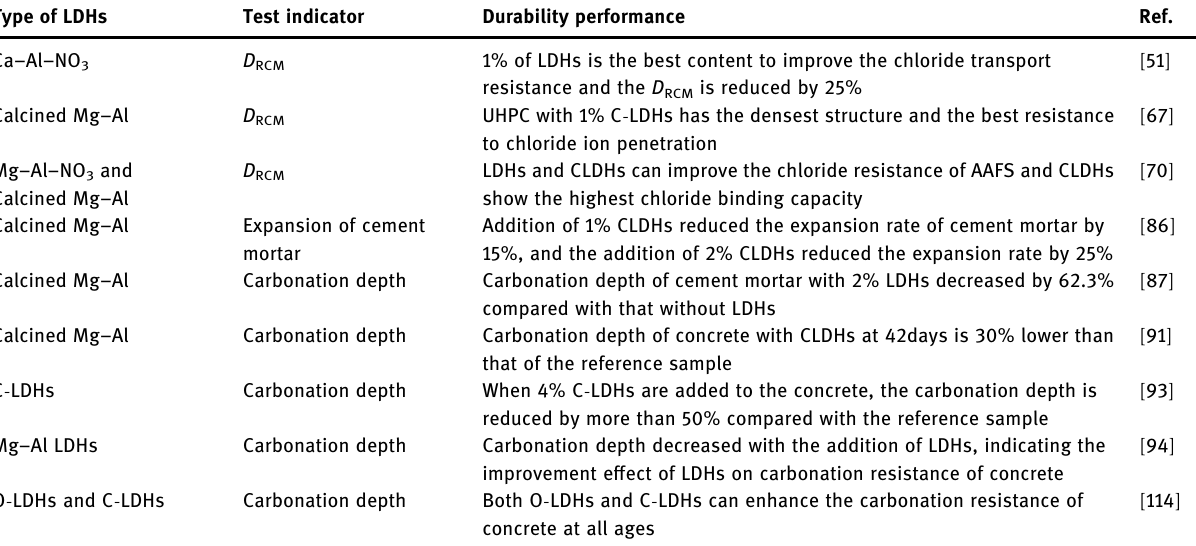
Table 2: E ff ect of LDHs on the durability of concrete Type of LDHs Test indicator